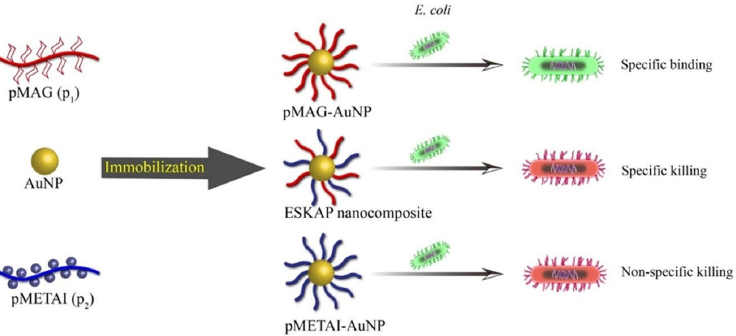
Figure 4. Schematic diagram of the bactericidal and recognition functions of gold nanoparticle com ‐ plexes regulated by modifying different polymers. Figure reproduced from ref. [29] with permis ‐ sion.